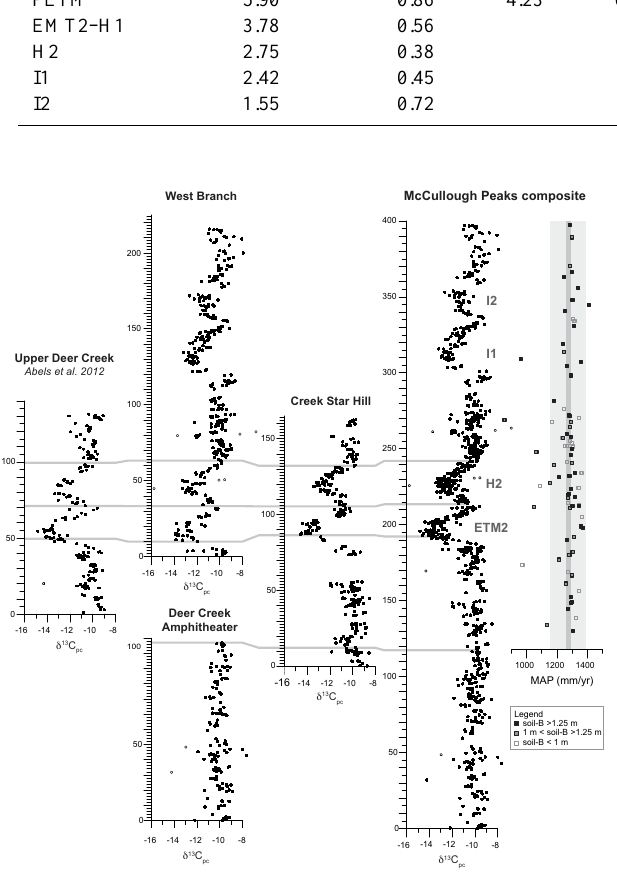
Figure 2. Carbon isotope stratigraphies of paleosol carbonate in the McCullough Peaks area, Bighorn Basin, Wyoming (USA). Shown are data from the Upper Deer Creek section of Abels et al. (2012), and the West Branch, Deer Creek Amphitheater, and Creek Star Hill sections. Grey horizontal lines represent field-based tracing of marker beds P1, P4, and P8 by which the McCullough Peaks composite carbon isotope stratigraphy has been constructed. To the right, mean annual precipitation reconstructions from the CAL- MAG methods are given on the McCullough Peaks composite stratigraphy. Different symbols denote different thickness of the soil-B horizons. Note that there is no obvious change in soil mois- ture during the four hyperthermal events.